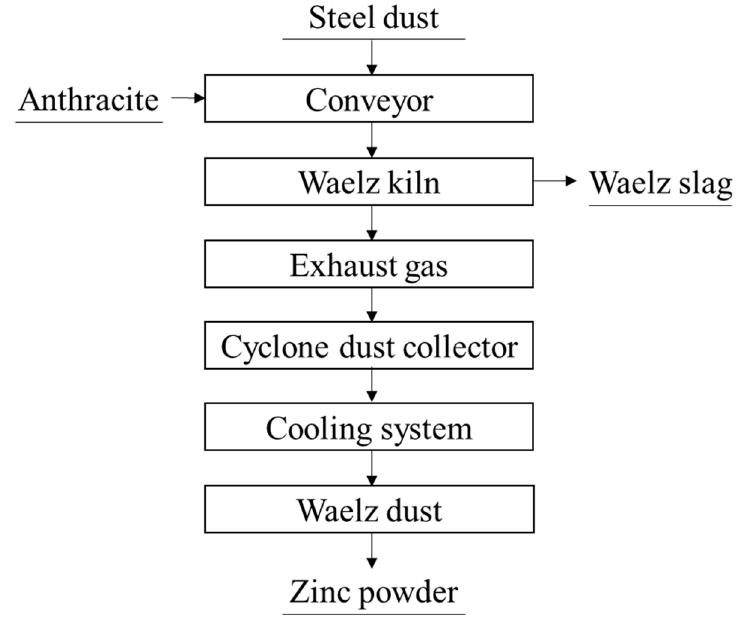
Figure 7. The Waelz process flow [8,13,36]. Figure 10. The Waelz process flow [8,13,36].